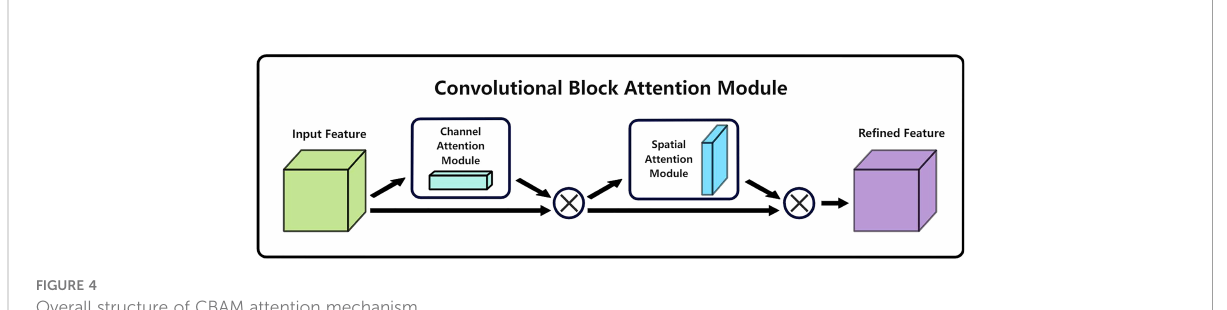
FIGURE 4 Overall structure of CBAM attention